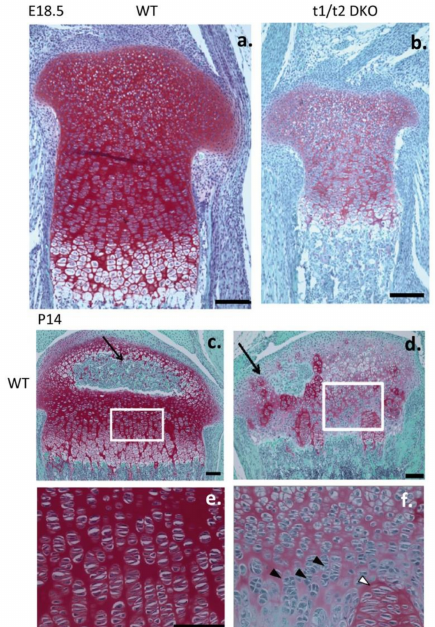
Figure 6. Chondroitin sulphate N -acetylgalactosaminyltransferase-1 and -2 (T1 / 2) knockout